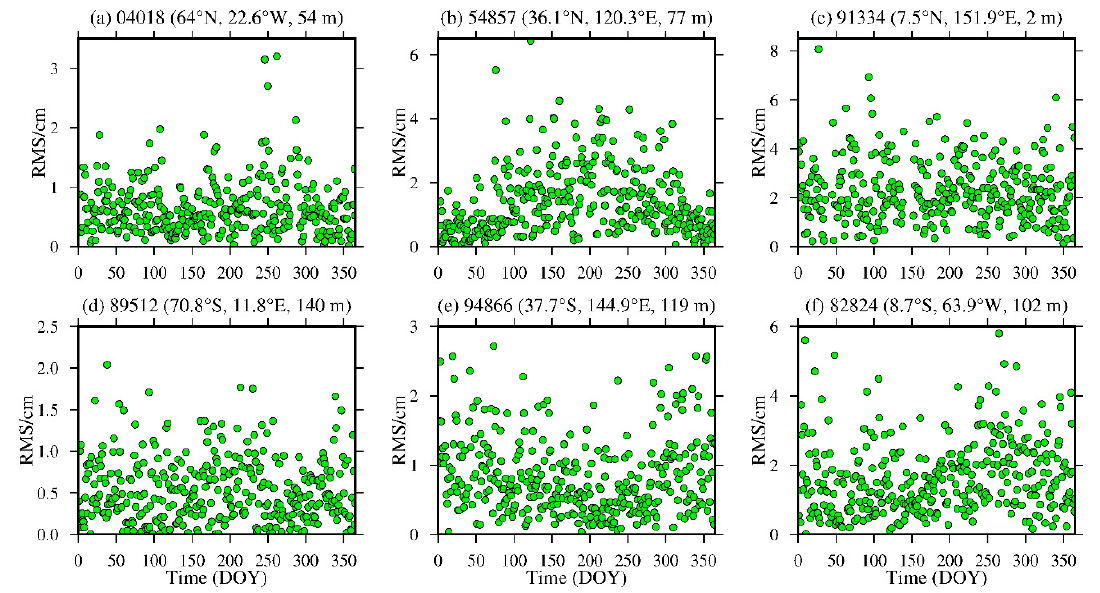
Figure 13. ZTD RMS time series of stations ( a ) 04018, ( b ) 54857, ( c ) 91334, ( d ) 89512, ( e ) 94866 and ( f ) 82824 derived from the MERRA-2 data from 2015 (the content in parentheses indicates the latitude, longitude and altitude of the radiosonde station).